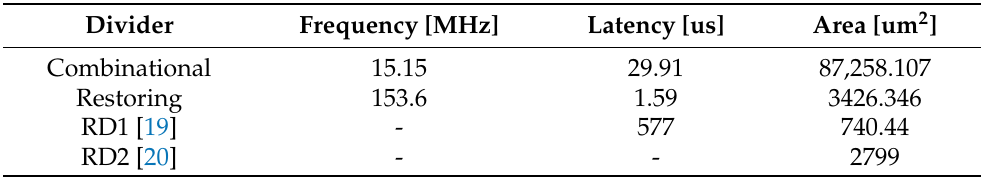
Table 1. Timing and Area results for the restoring